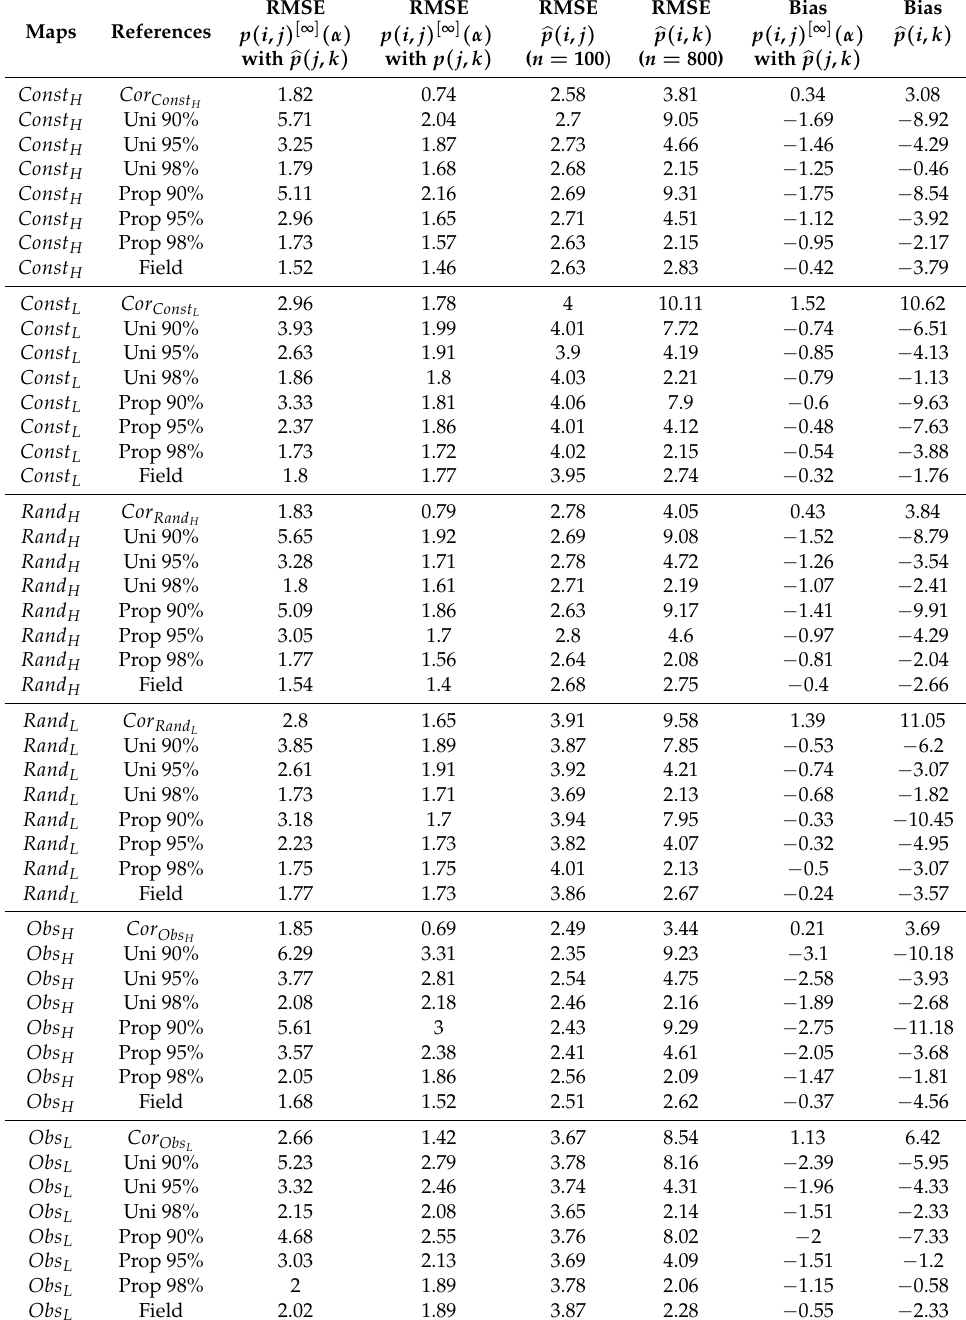
Table 3. Comparison between the different methods for estimating the confusion matrix of a map. Each simulated map (first column) is validated with each reference dataset (second column) with conditionally independent errors, as well as with the reference dataset correlated to it by design (named Corr MapName ). The RMSE ( n = 200) on the estimated (cid:100) OA ( i , j ) compared with the theoretical OA ( i , j ) are provided in columns 3 to 6. In addition, the last two columns show the bias of the MaxEnt and the p ( i , k )